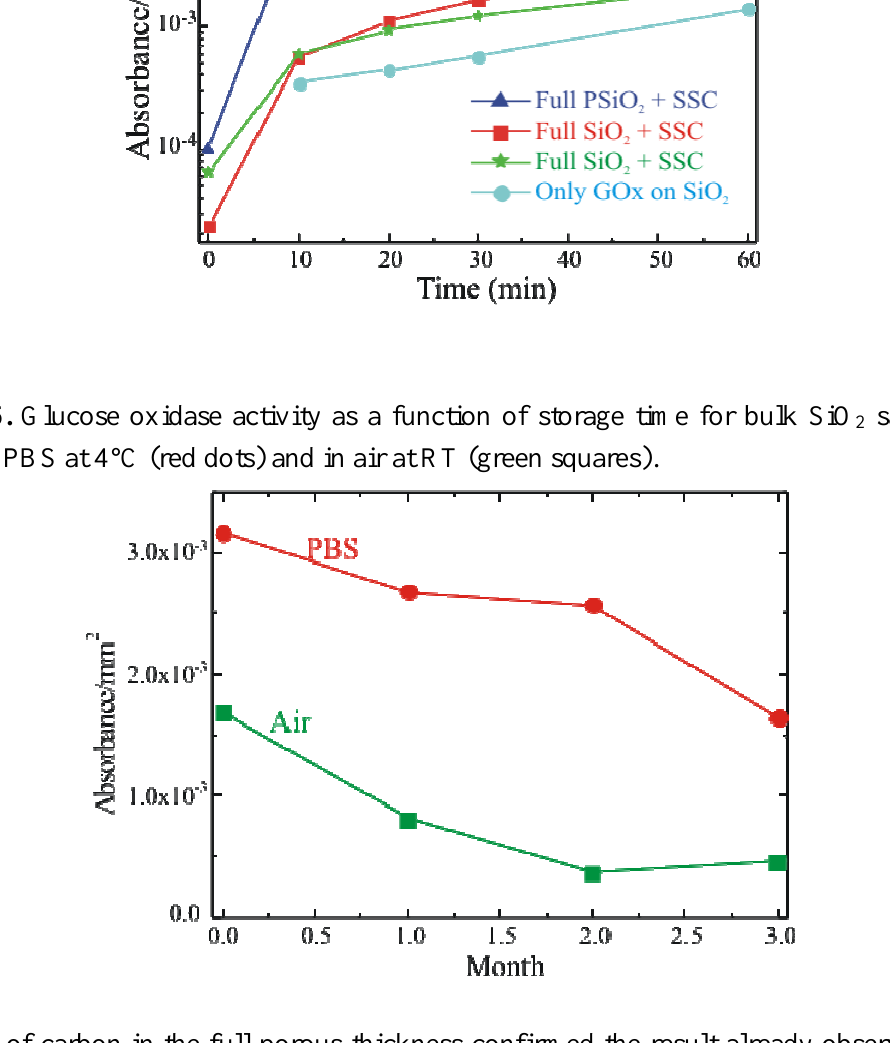
Figure 4. Glucose oxidase activity as a function of time for: bulk SiO processed without SSC (green stars, Full-SSC), bulk SiO SSC (red squares, Full+SSC), bulk SiO sample fully processed with SSC (dark blue triangles).